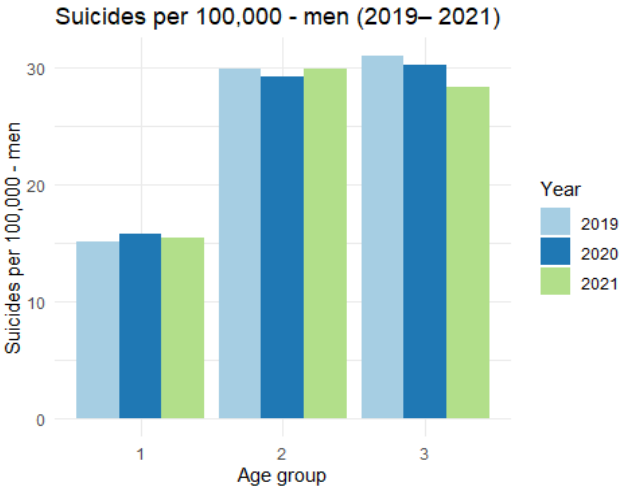
Table 6. Number of suicides per 100,000—men (2019–2021).